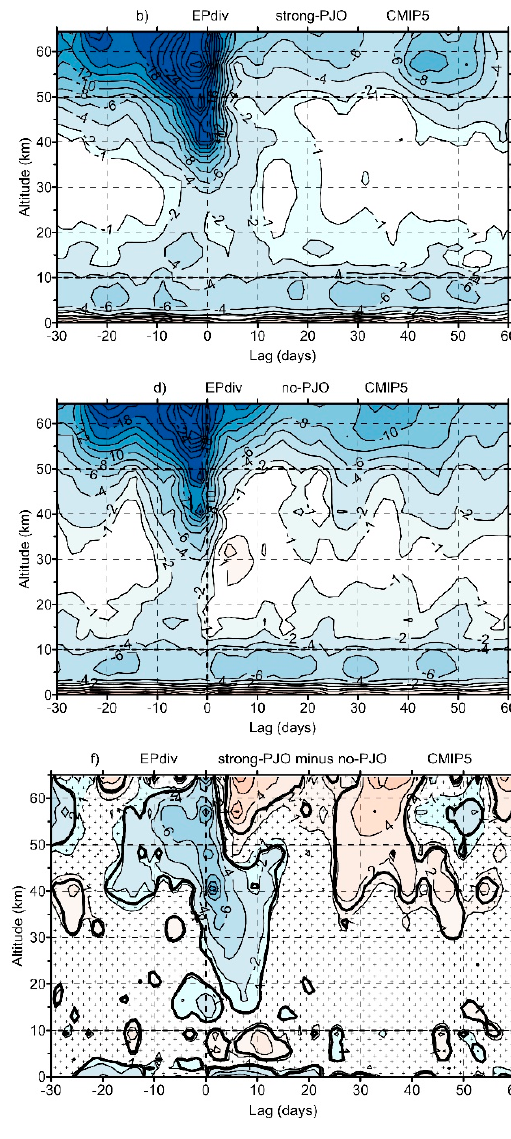
Figure 5. CMIP5-ESM-LR: Same as Figure Figure 5. CMIP5 ‐ ESM ‐ LR: Same as Figure 4.